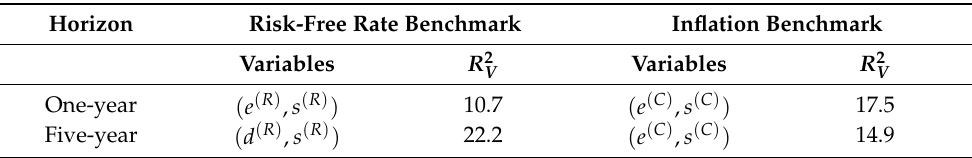
Table 5. Summarized optimal combinations of predictive variables and their predictive power R 2 V